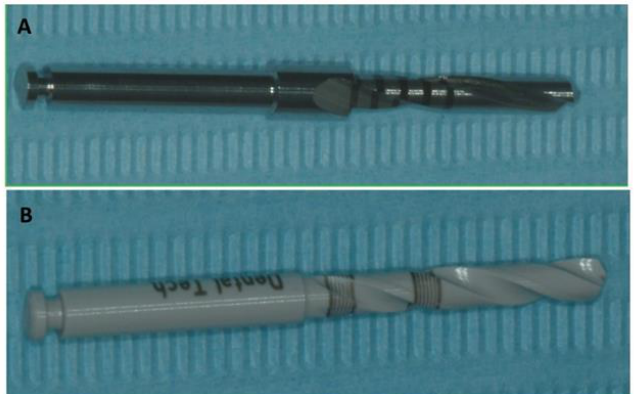
Figure 1. ( A ) Aspect of the stainless steel (SS) drill. (B ) The aspect zirconia drill.